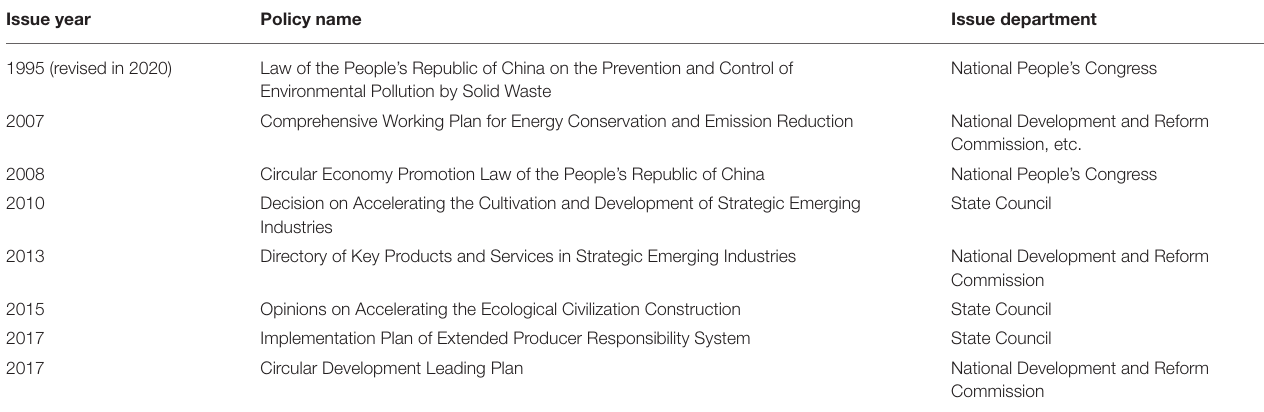
TABLE 3 | China’s circular economy policies and regulations